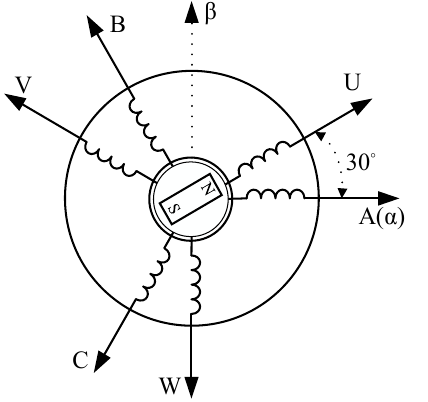
Figure 1. Distribution of the stator windings of the dual three-phase PMSM.